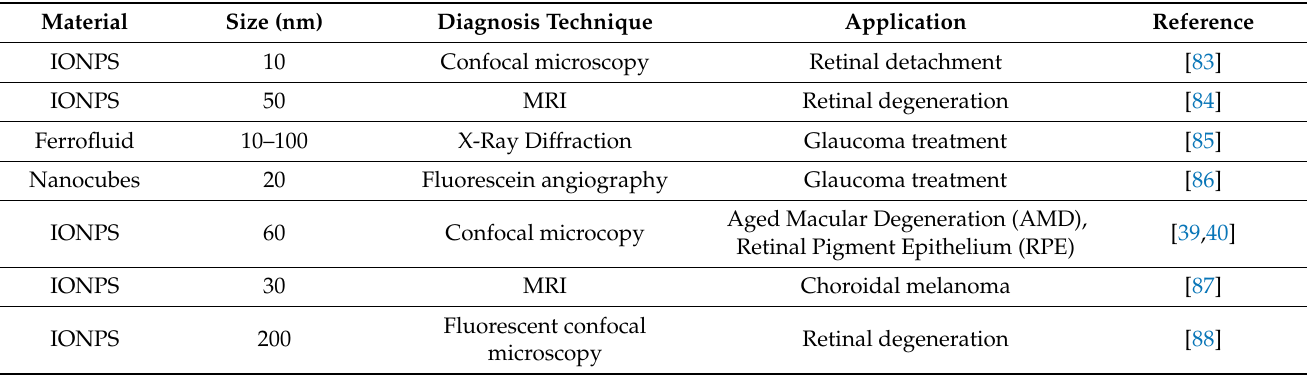
Table 1. Clinical nanoparticle-based strategies for ocular disease